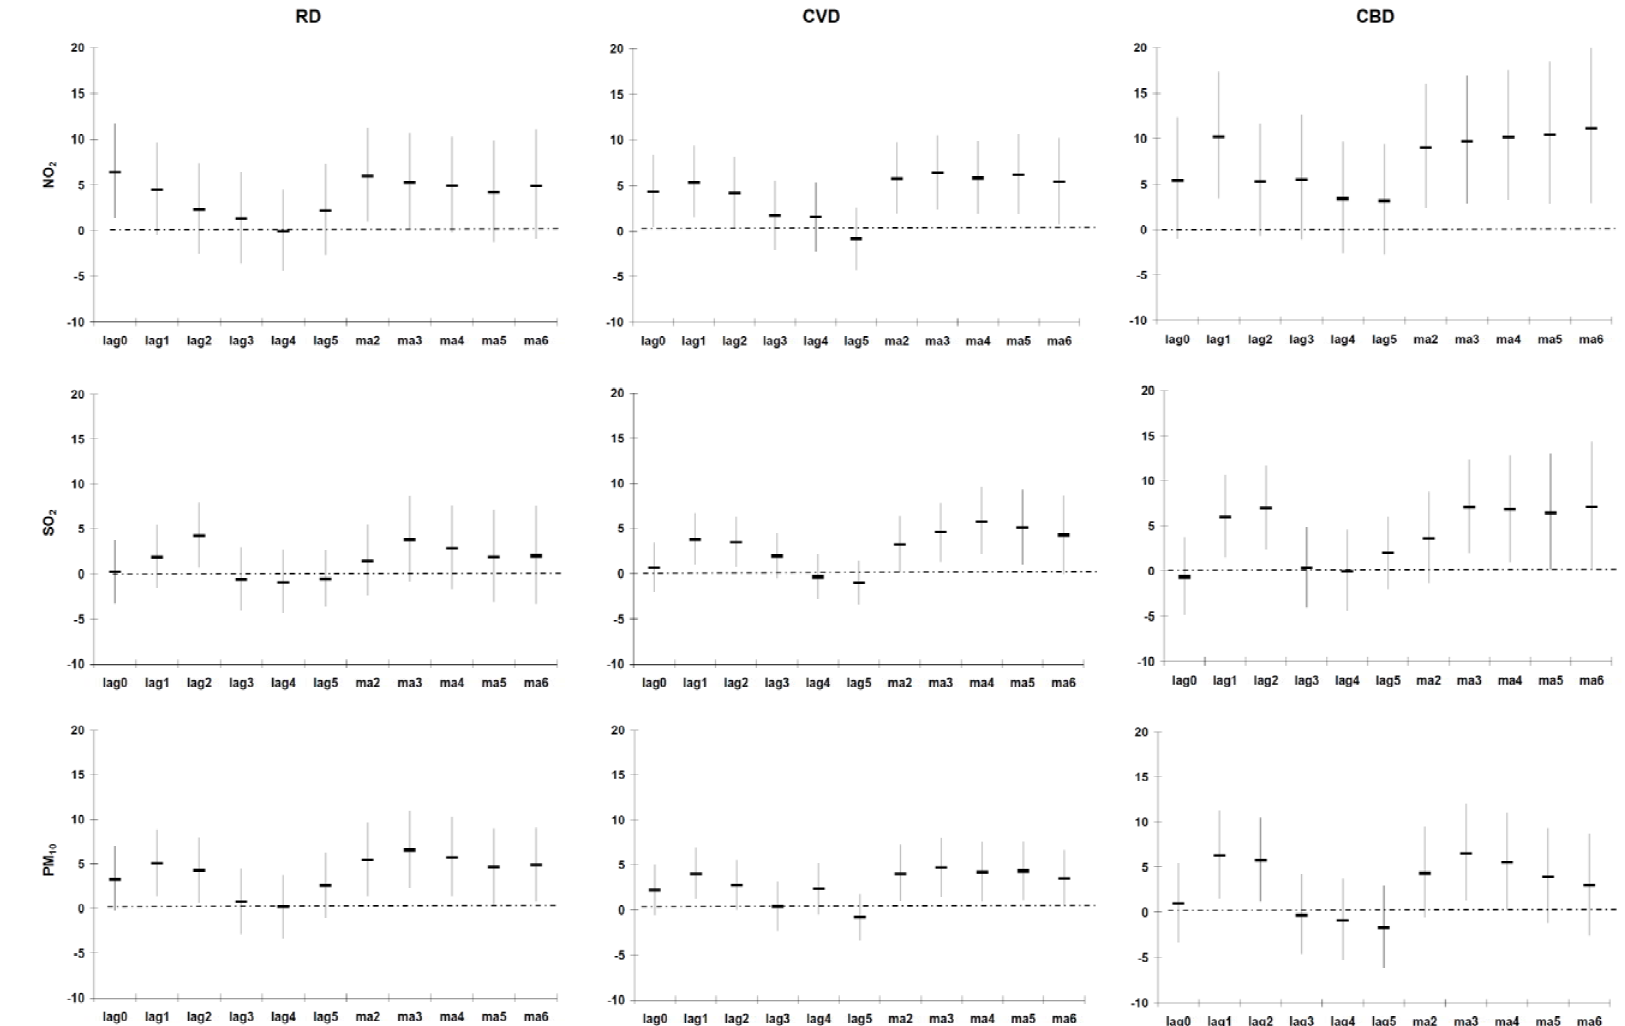
Figure A6. Percentage change (95% CI) in cause-specific mortality in Cape Town per inter-quartile range increase in PM during 2001–2006 (warm period), adjusted for Tapp, rainfall, wind speed and public